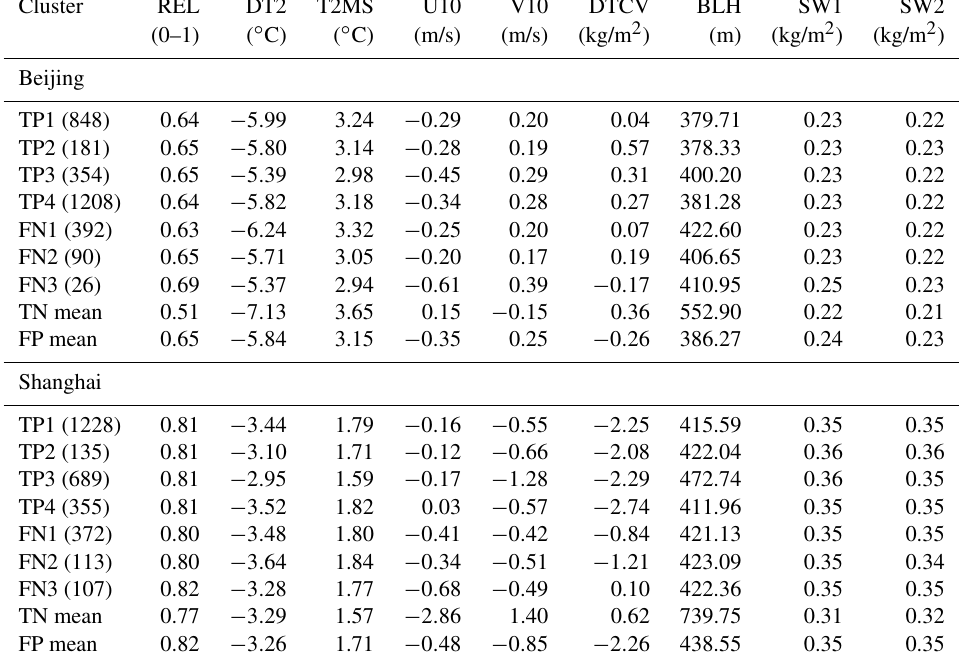
Table 1. Cluster means of features associated with haze events (TP and FN) in Beijing and Shanghai versus means of all clusters of non-haze events of TN and FP. The number of cluster members in each cluster is listed in